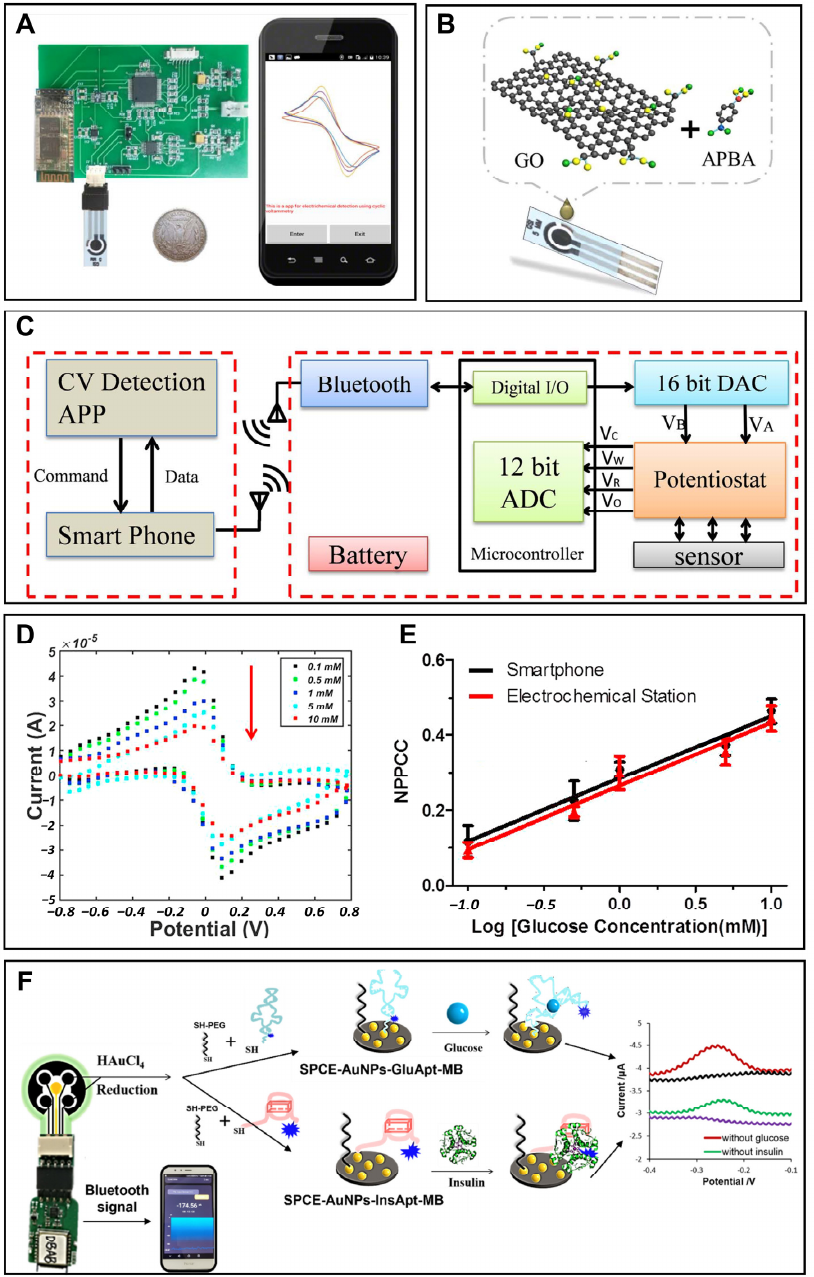
1 Figure 2. Smartphone-based portable glucose monitoring. ( A ) A smartphone-based glucose detection system with a modified glucose electrode, a portable electrochemical circuit board and a